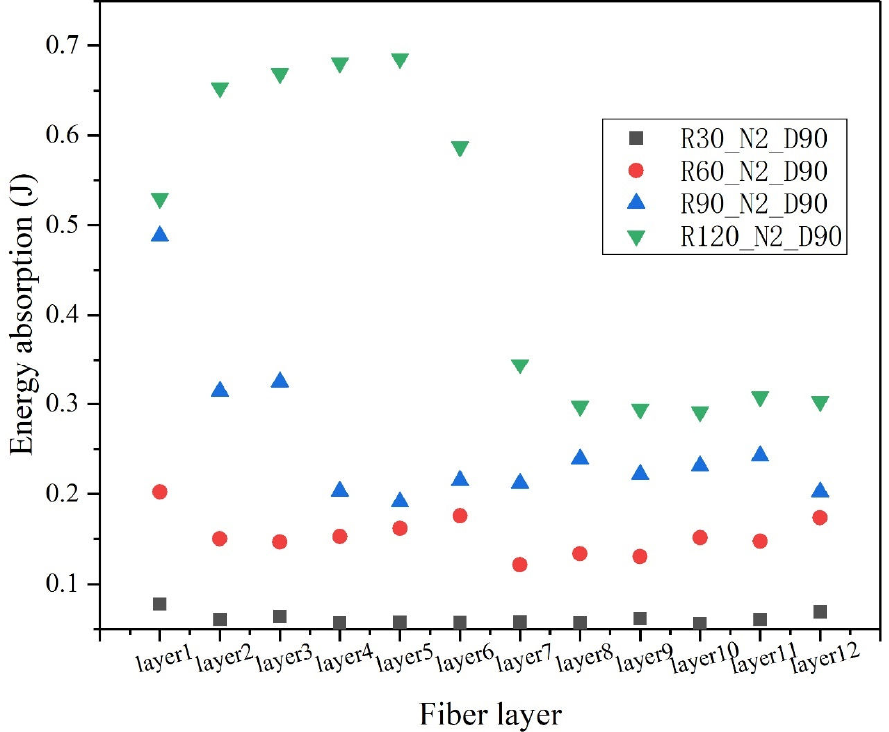
Figure 17. Fiber layer energy distribution.